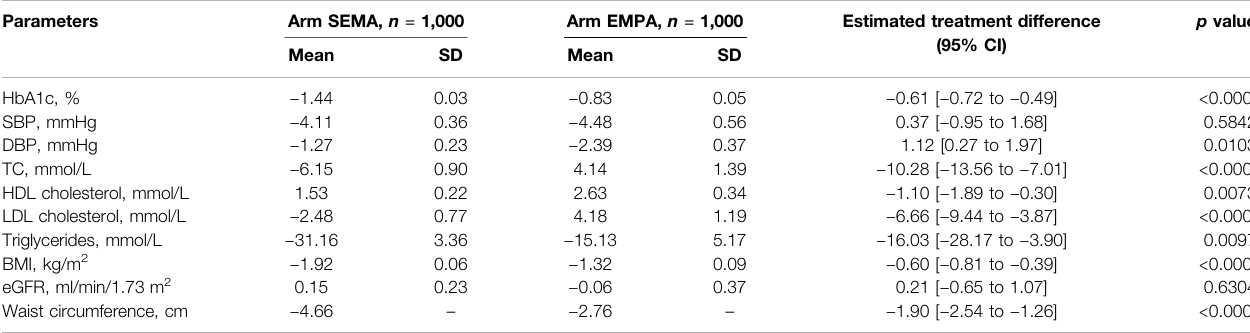
TABLE 2 | Mean changes from baseline at 52 weeks ef fi cacy end points.